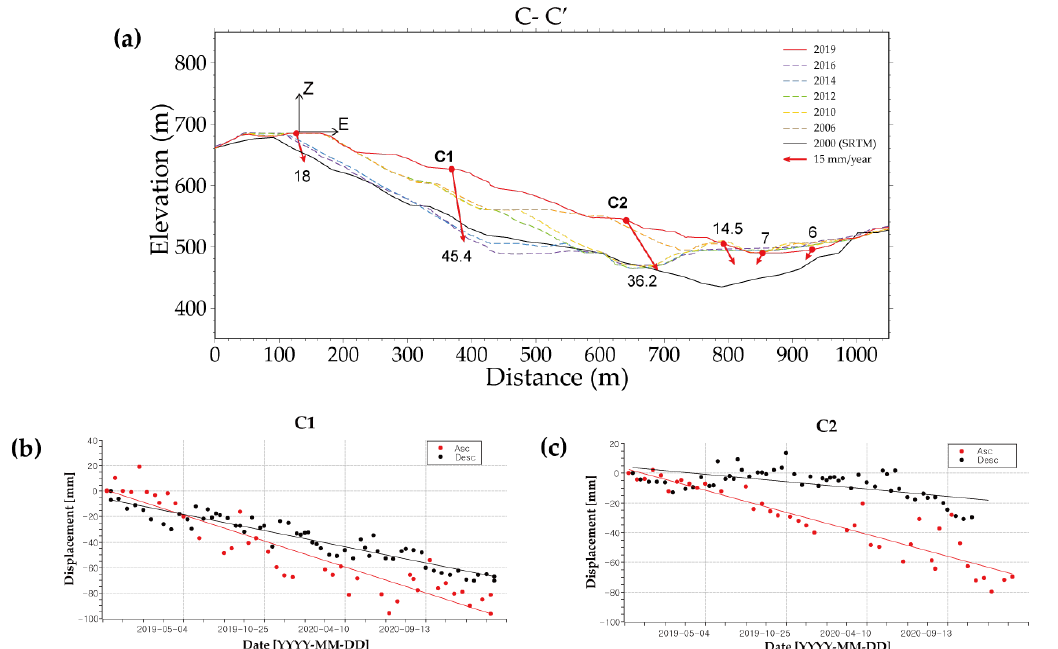
Figure 9. Elevation change and displacement along the C-C’ on the slope of the tailings storage area. ( a ) Cross section of C-C’, and change along the slope and time-series plots of displacement in ( b ) C1 and ( c ) C2 from the ascending and descending orbits with arbitrary offsets. The DEM was obtained from the National Geographic Information Service of Korea, except for the SRTM in 2000.